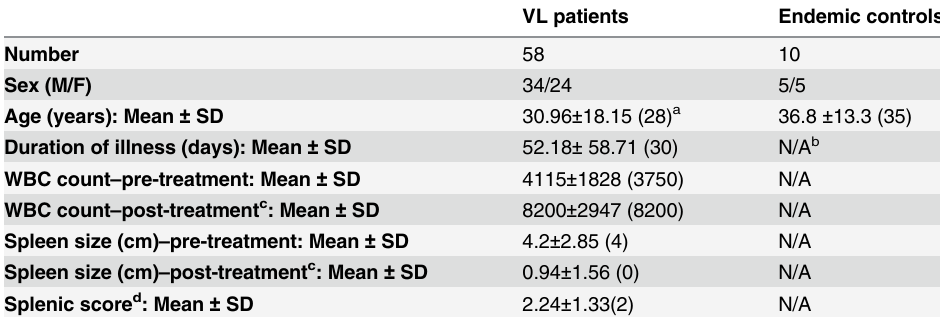
a Values in parentheses represent median values.